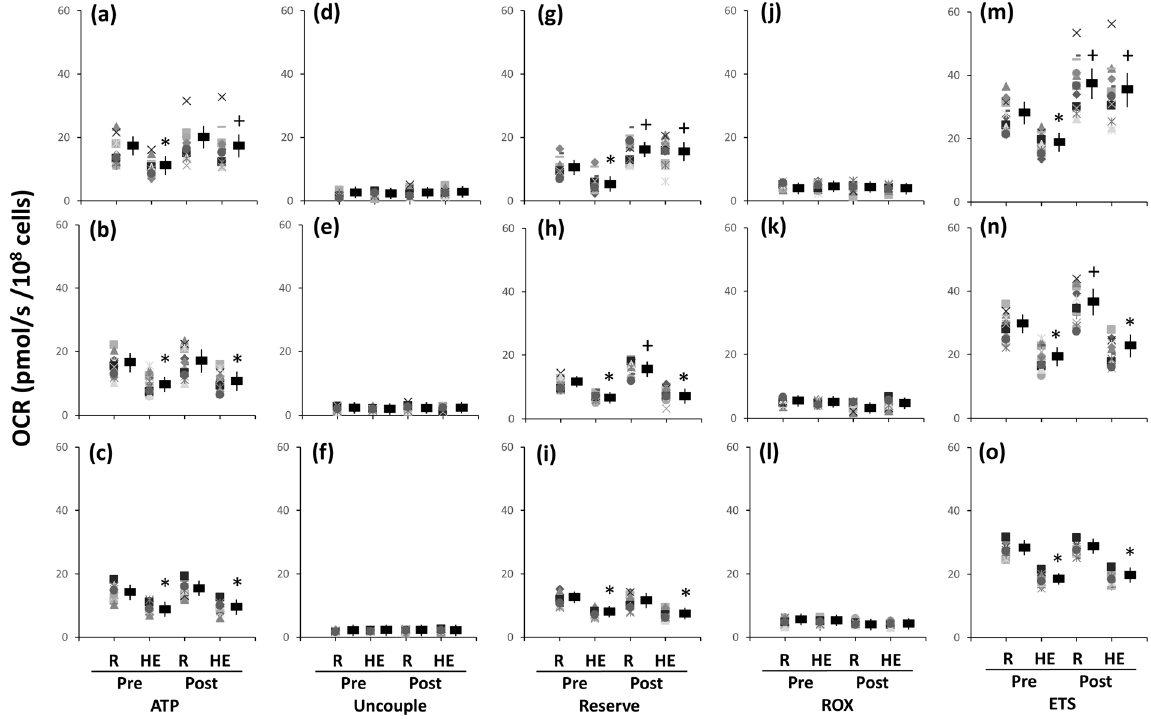
Figure 4. Effects of interval and continuous exercise regimens on mitochondrial O 2 consumption rate (OCR) in the intact platelets. HIT (a , d , g , j , m) , high-intensity interval training group; MCT (b , e , h , k , n) , moderate- intensity continuous training; CTL (c , f , i , l , o) , control group; Pre , pre-intervention; Post , post-intervention; R , resting; HE , hypoxic (12%O 2 ) exercise test; ATP , ATP-linked OCR; Uncouple , uncouple OCR; RESERVE , the reserve capacity of OCR; ROX , residual O 2 consumption. * P < 0.05, R vs. HE ; + P < 0.05, Pre vs. Post . Values were mean ±